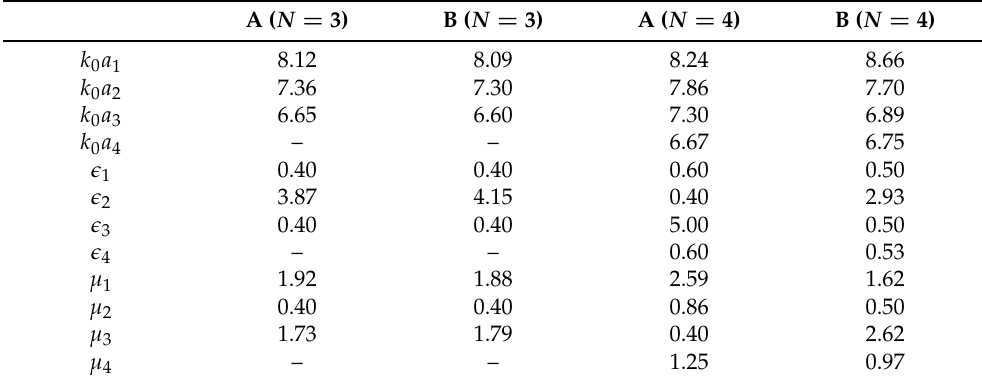
Table A1. Values of the optimization variables for optimized designs A and B of Figure 2.